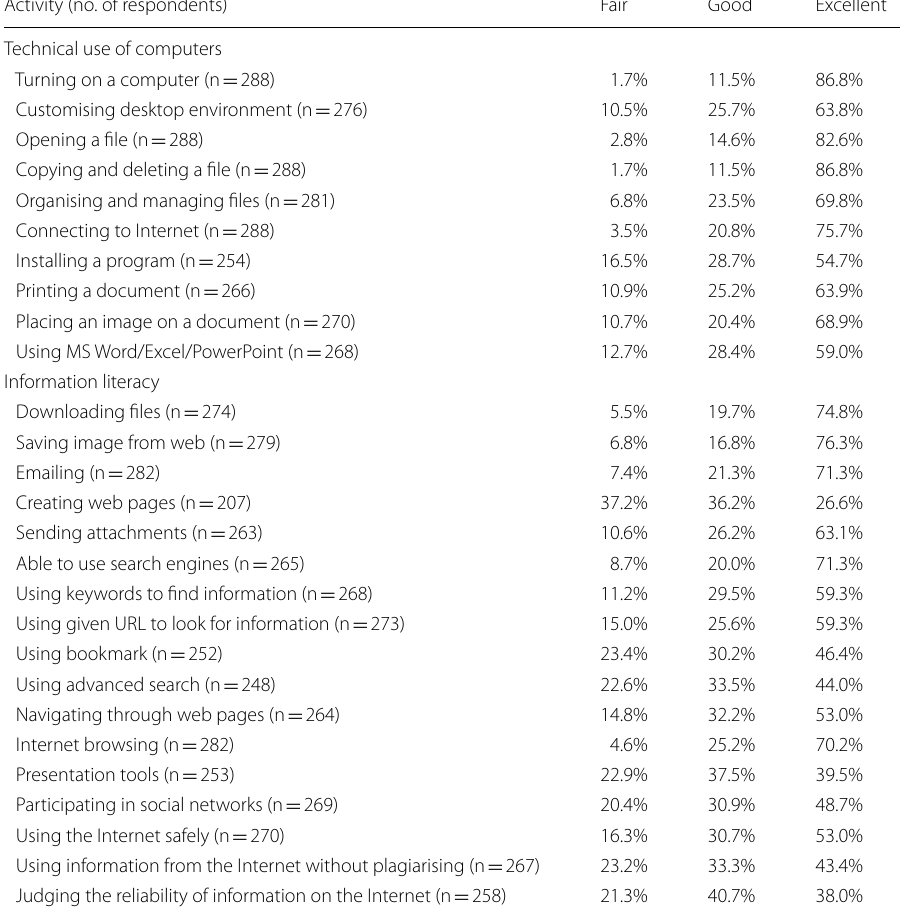
Table 3 Self-reported ratings of students for the technical use of computers and their information literacy, with a particular focus on the internet Activity (no. of